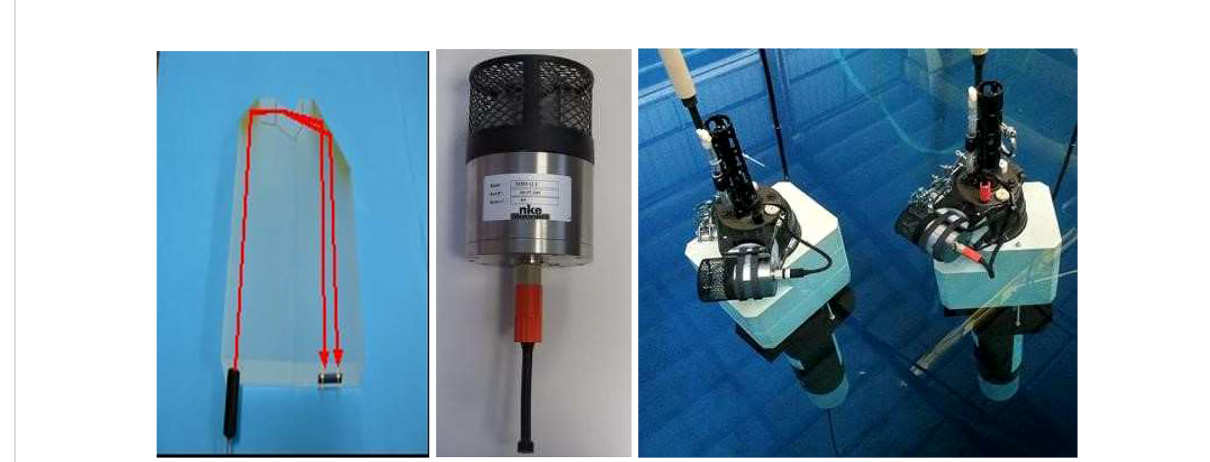
FIGURE 1 On the left, the principle of a V-block refractometer. In the middle, photo of the NOSS V-block refractometer. On the right, photo of the NOSS on PROVOR Argo pro fi